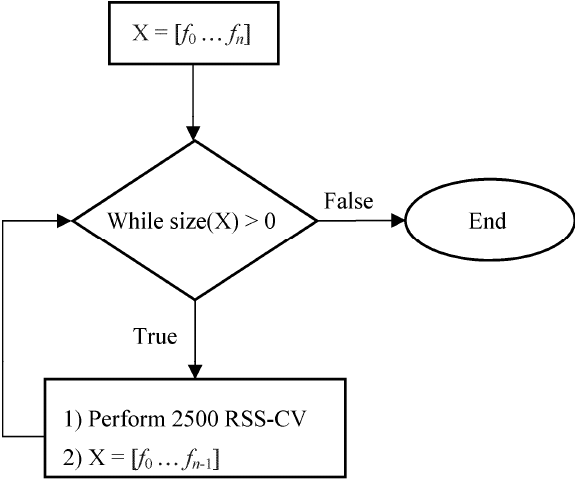
Figure 5. Test III procedure for testing most frequently occurring feature subsets.